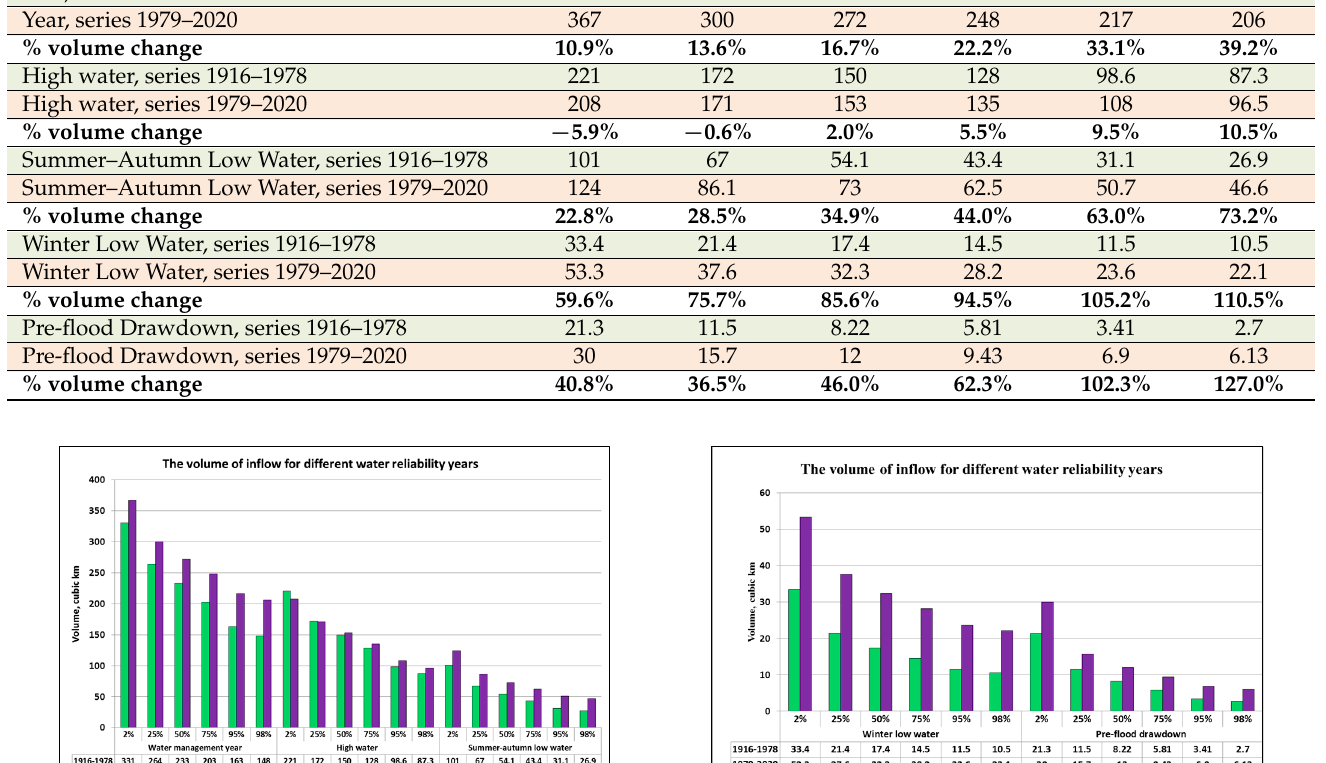
Figure 10. The volume of in fl ow for two long-term series by seasons and years of di ff erent reliability by in fl ow.